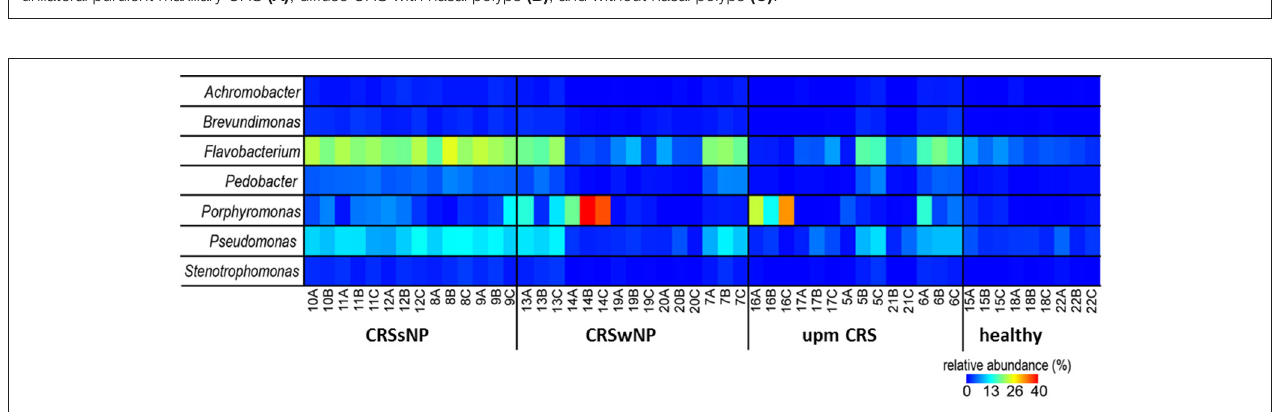
FIGURE 3 | Non-metric multidimensional scaling plots based on Bray-Curtis dissimilarity of the healthy samples (dot) compared to the inflamed samples (circle) in unilateral purulent maxillary CRS (A) , diffuse CRS with nasal polyps (B) , and without nasal polyps (C) .